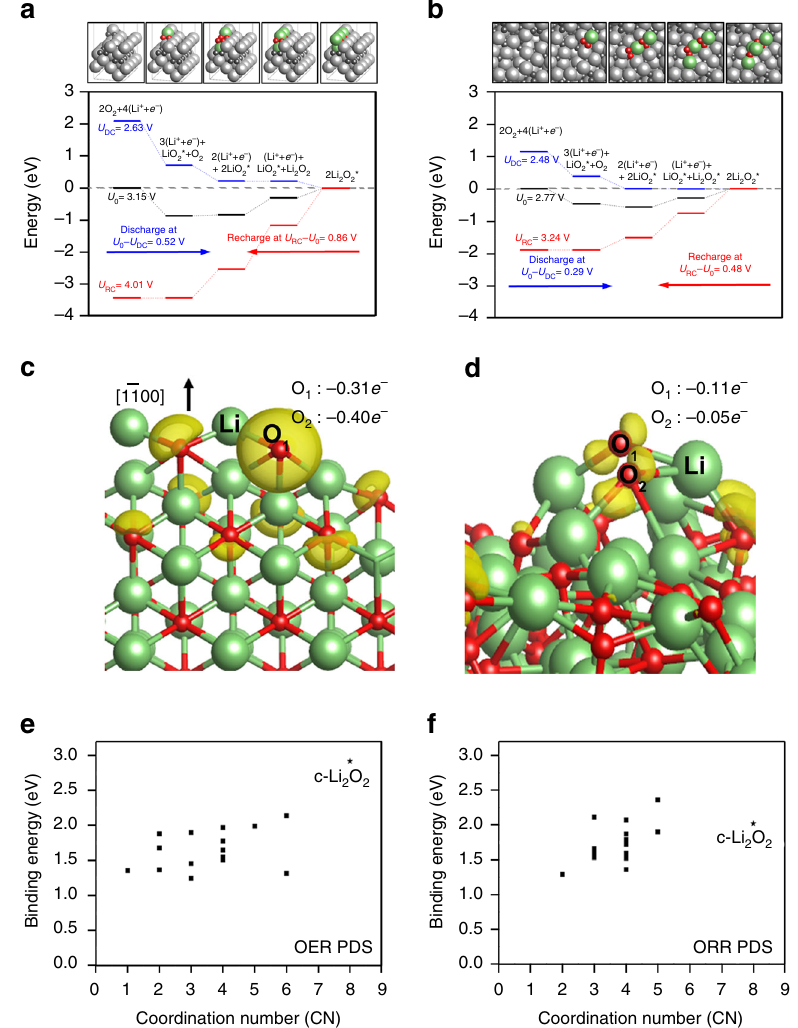
Fig. 4 Density functional calculations and Bader charge analysis. a , b Calculated free energy diagrams a on the Li 2 O 2 ð 1100 Þ and b on amorphous Li 2 O 2 , along with the optimized structures. For the amorphous surface, the most favorable adsorption site was considered to construct the diagram. Lithium is colored in light gray (bulk) and light green (adsorbate); oxygen is colored in dark gray (bulk) and red (adsorbate). c , d The variation in electron density upon the fi rst LiO 2 adsorption on c the crystalline Li 2 O 2 ð 1100 Þ and d amorphous Li 2 O 2 surfaces. The charge density indicated by surface contour is plotted with a threshold value of 0.01e Å − 3 . The newly adsorbing *LiO 2 is denoted explicitly as Li, O 1 , and O 2 . O 2 which is not shown in c is behind O 1 . Lithium is in light green and oxygen in red. e , f Binding energies of e 1st LiO 2 and f 2nd LiO 2 for 16 sites of the amorphous Li 2 O 2 surface plotted versus coordination number. Binding energies on the crystalline surface are also shown for comparison, denoted as c-Li 2 O